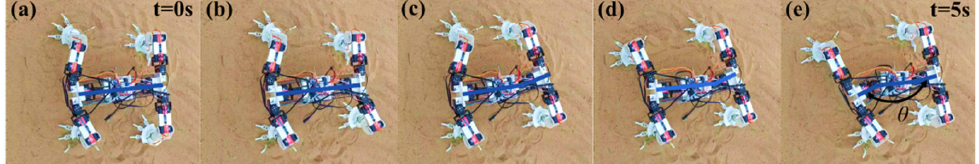
Figure 20. Turning gait test; ( a – e ) five movements in one locomotion cycle.